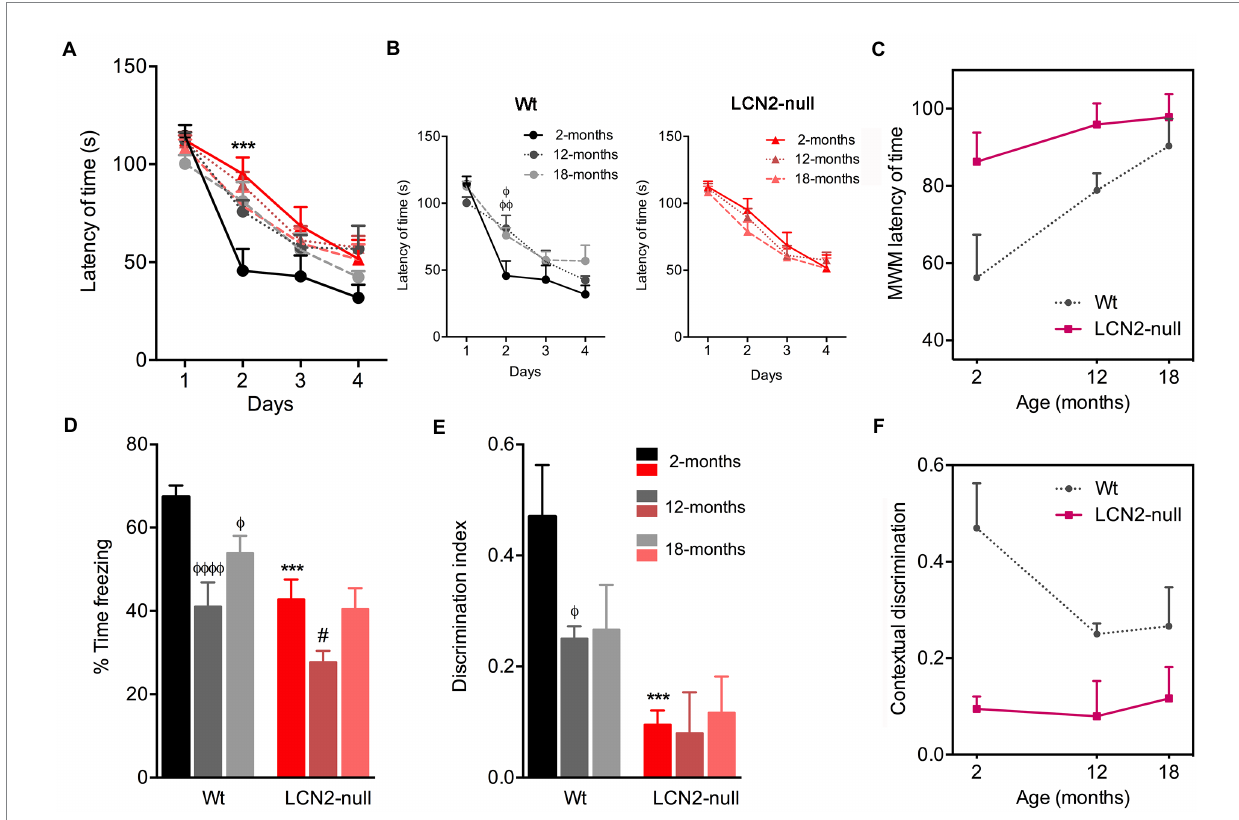
FIGURE 4 Spatial learning and memory retrieval and consolidation decreases during normal aging. (A) Analysis of spatial learning and memory in the Morris water maze (MWM) test revealed that all groups learned to find the position of the hidden platform across the 4 days of acquisition. (B) Older Wt mice required more time to find the platform, while lipocalin-2 (LCN2)-null animals presented similar impaired learning curves throughout aging ( n = 10–12 mice per group). (C) Cognitive deficits in the course of normal aging, measured by the reduced latency of time in the MWM. (D) Freezing behavior upon re-exposure to conditioning context revealed a major effect of aging in Wt animals, as freezing behavior decreased in older animals. (E) Impaired memory retrieval and consolidation was confirmed by the decreased ratio of discrimination index in aged Wt mice, which was sustained in LCN2-null mice throughout aging (n = 10–12 mice per group). (F) Impaired contextual discrimination along aging in Wt and LCN2-null mice. Data are presented as mean ± SEM, analyzed by two-way ANOVA with Bonferroni’s multiple comparison test. Φ Denotes differences between young and aged Wt mice; ≤